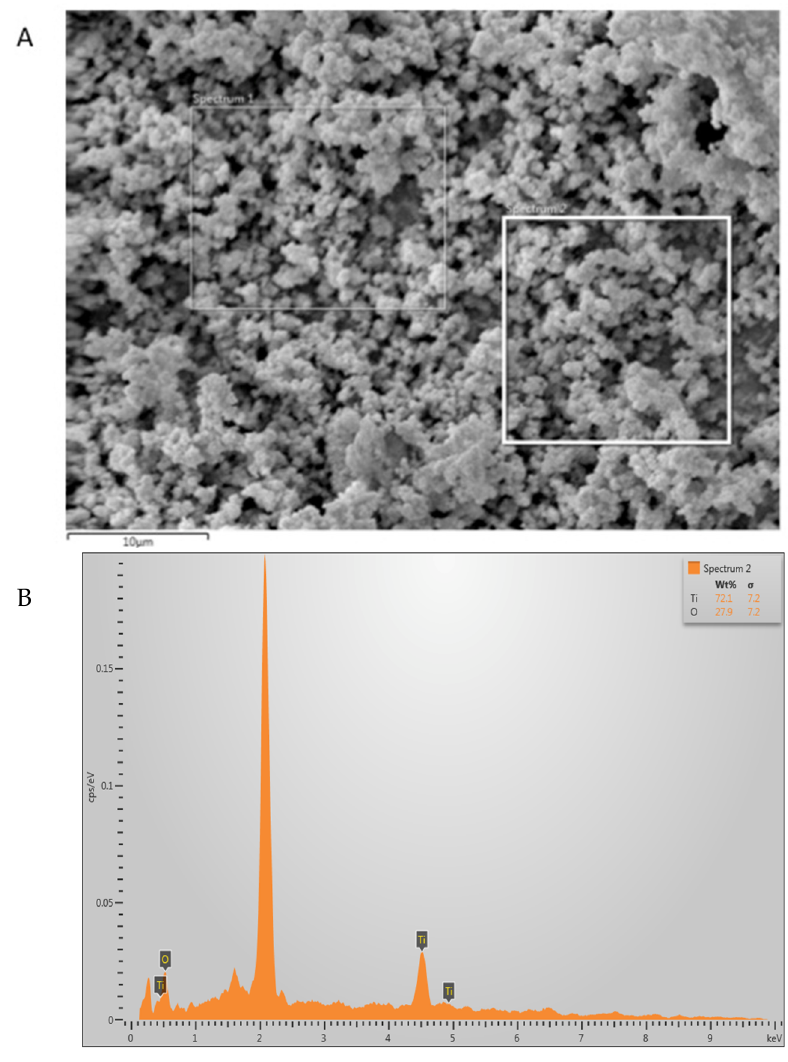
Figure 1. High-magnification ( A ) SEM image of the nano-titanium oxide (TiO 2 ) particles. The TiO 2 powder showed agglomerated particles of various irregularly sized polygonal crystals, ranging from 500 nm to 1000 nm. ( B ) Representative EDX graph showing high percentage of Ti and oxygen.